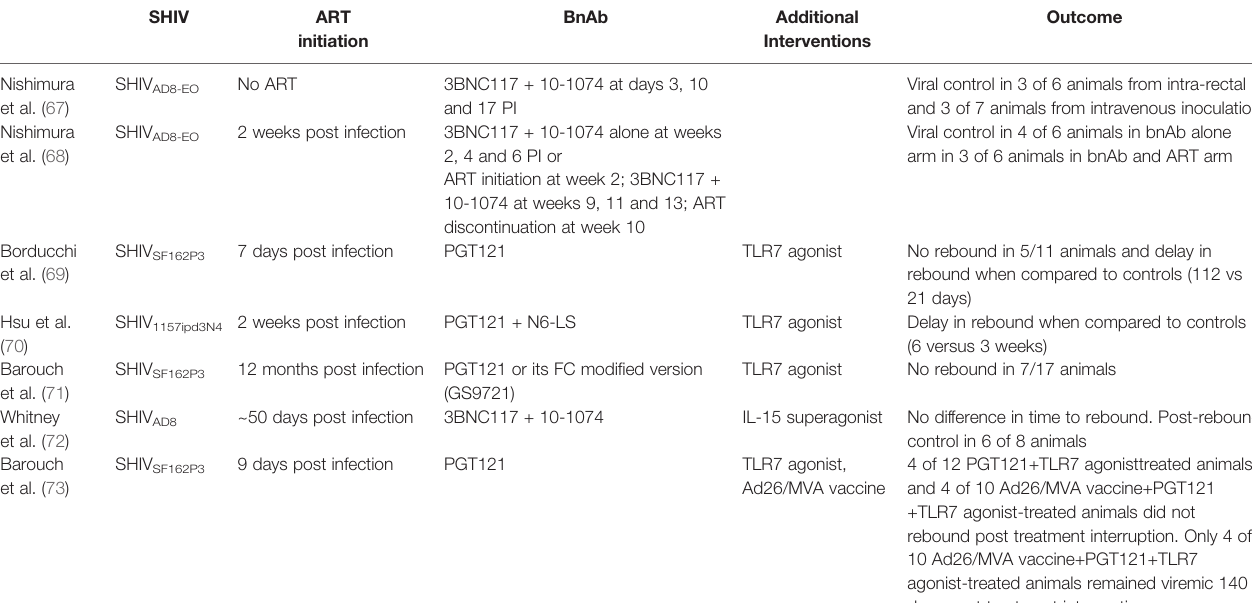
TABLE 2 | Non-human primate studies on the use of bnAbs to target, control and potentially eliminate the viral reservoir.